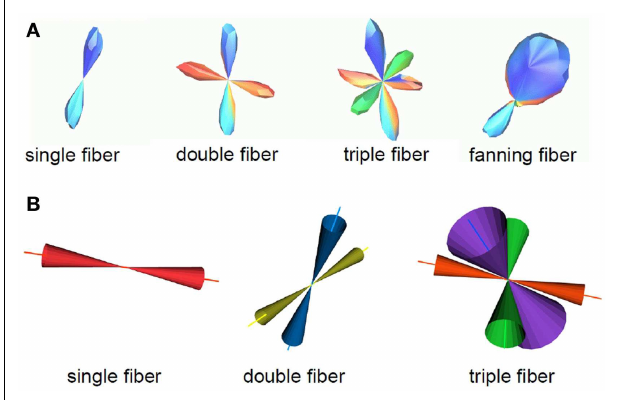
FIGURE 2 |A summary of the fiber configurations obtained from the probabilistic curve inference labeling is shown . (A) PDFs for the direction of propagation of tractography.The algorithm produces output for four possible configurations, which are, from left to right, a single (potentially curving) fiber bundle, double crossing, triple crossing, and fanning fibers.These distributions come from one b = 3000s/mm 2 dataset on which curve inference was run. (B) Confidence intervals for the mean of these distributions are also obtained. Here, the 95% confidence intervals for the mean fiber ODF maximum are shown for the non-fanning cases, using the b = 1000s/mm 2